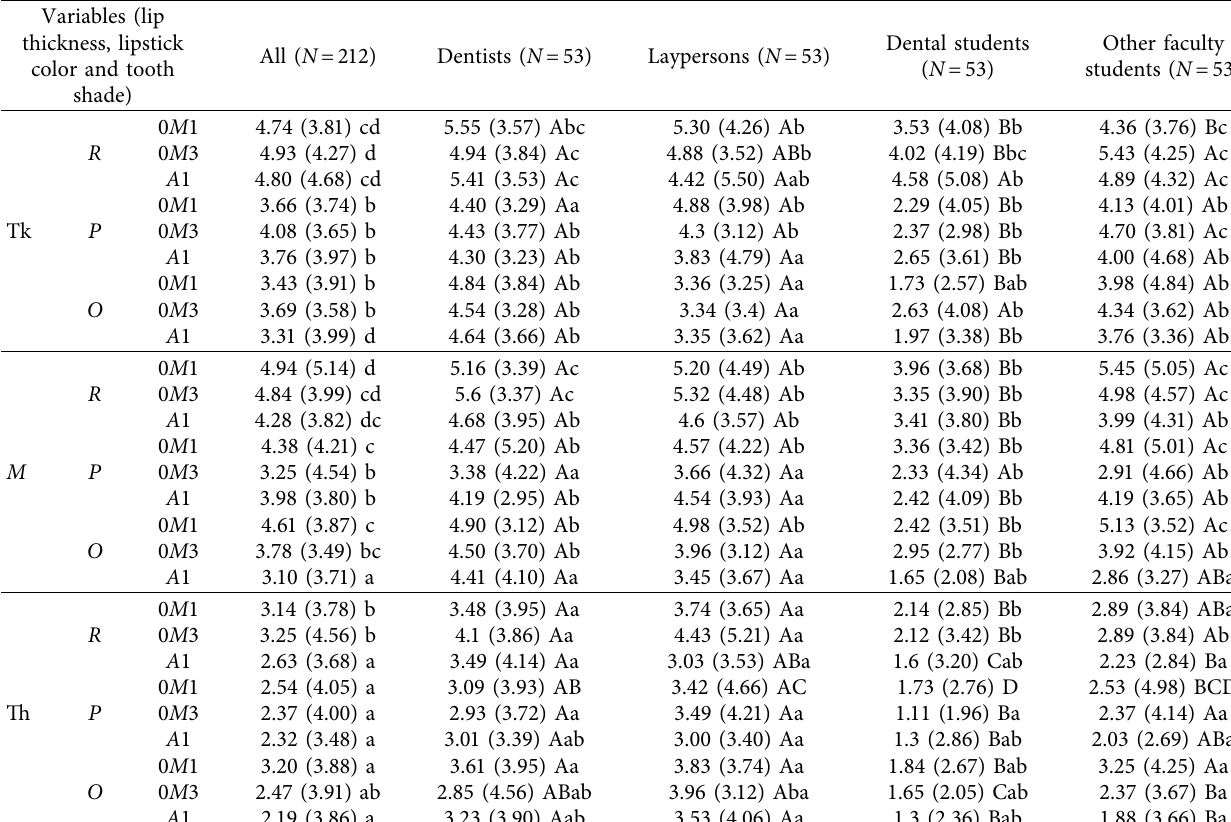
Table 1: Median (interquartile range) visual analog scale scores for smile attractiveness perception as evaluated using a combination variable (lip thickness × lipstick color × tooth shade) by all participants and each rater